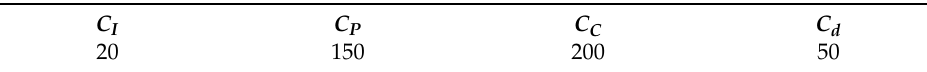
Table 1. Related cost